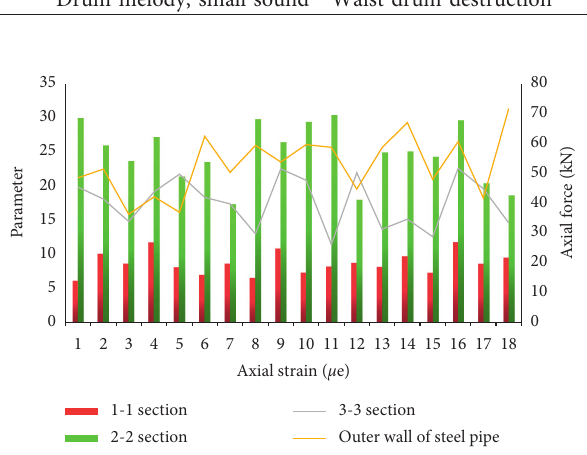
Figure 7: Data analysis result of mathematical expectation of experimental data. Table 5: Loading temperature and ultimate bearing capacity.